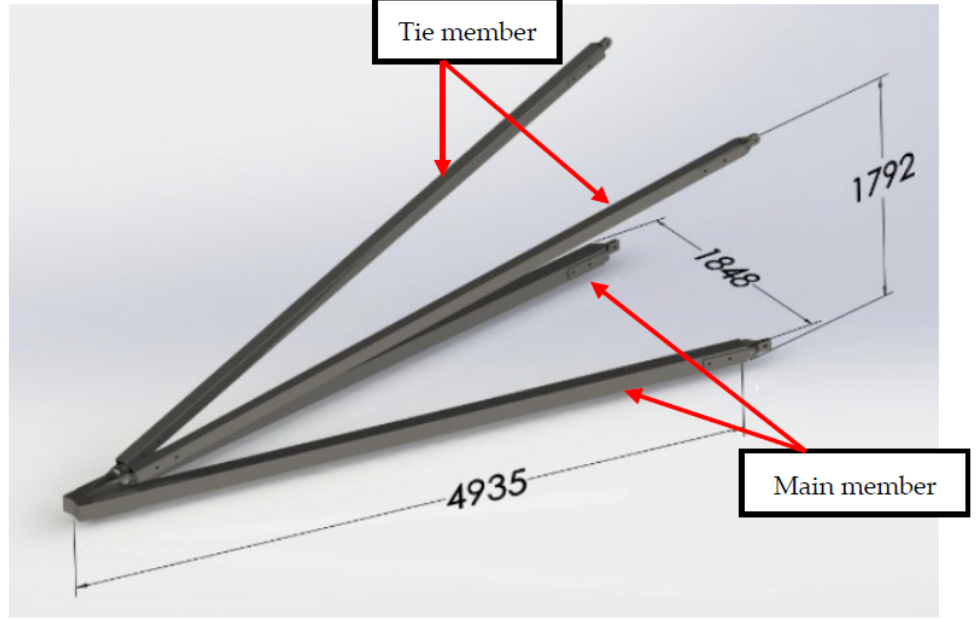
Figure 2. Three ‐ dimensional view and dimension of GFRP composite cross ‐ arm (in mm). Figure 2. Three-dimensional view and dimension of GFRP composite cross-arm (in